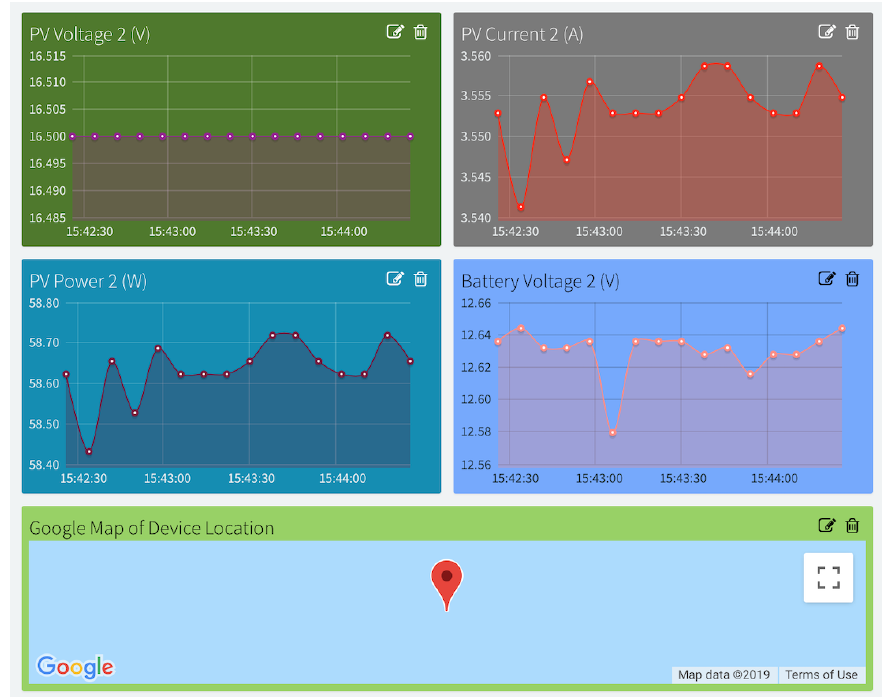
Figure 14. Created Dashboard (B) showing real-time